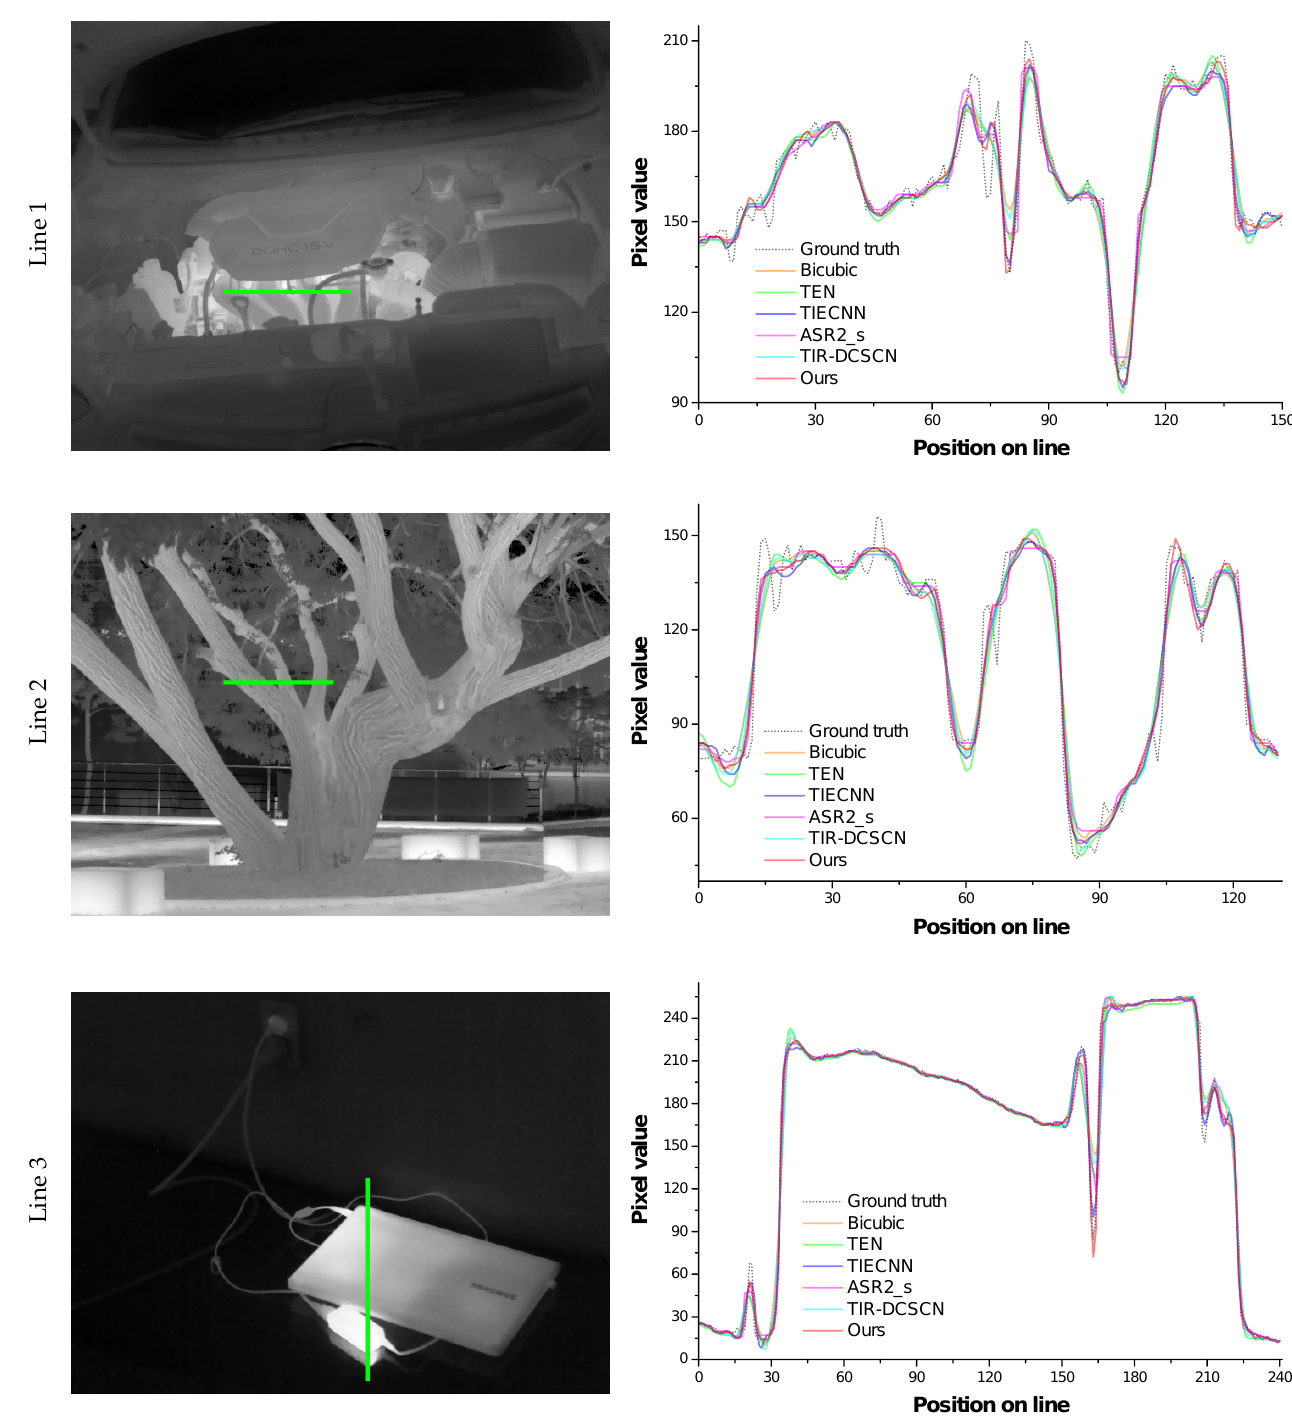
Figure 14. Comparison of line profiles (green-colored line) for the quantitative analysis using pixel values (top: [12]- thermal_072-S, middle; [29]-T138-No.48; bottom: [29]-T138-No.30).